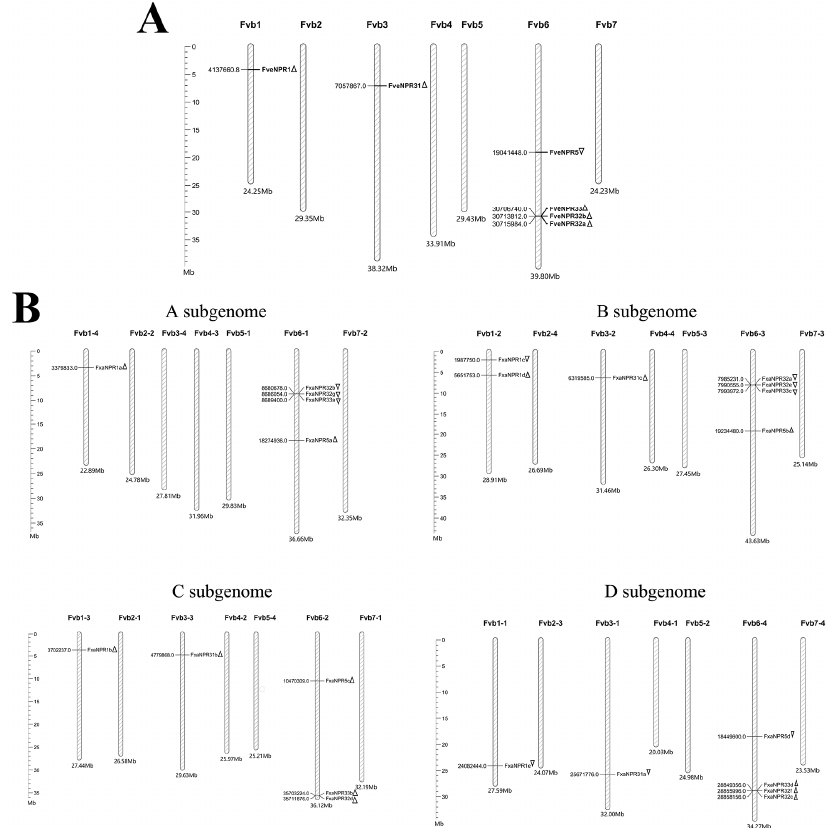
Figure 4. The chromosomal distributions of NPR1 -like genes in Fragaria vesca ( A ) and F. × ananassa ( B ). The identity of each chromosome (of certain sub-genome) is shown at the top. The scale ruler at the left side indicates the physical distance of chromosomes in megabases (Mb). The location site and the transcriptional direction for each strawberry NPR1 -like locus are marked as triangle.